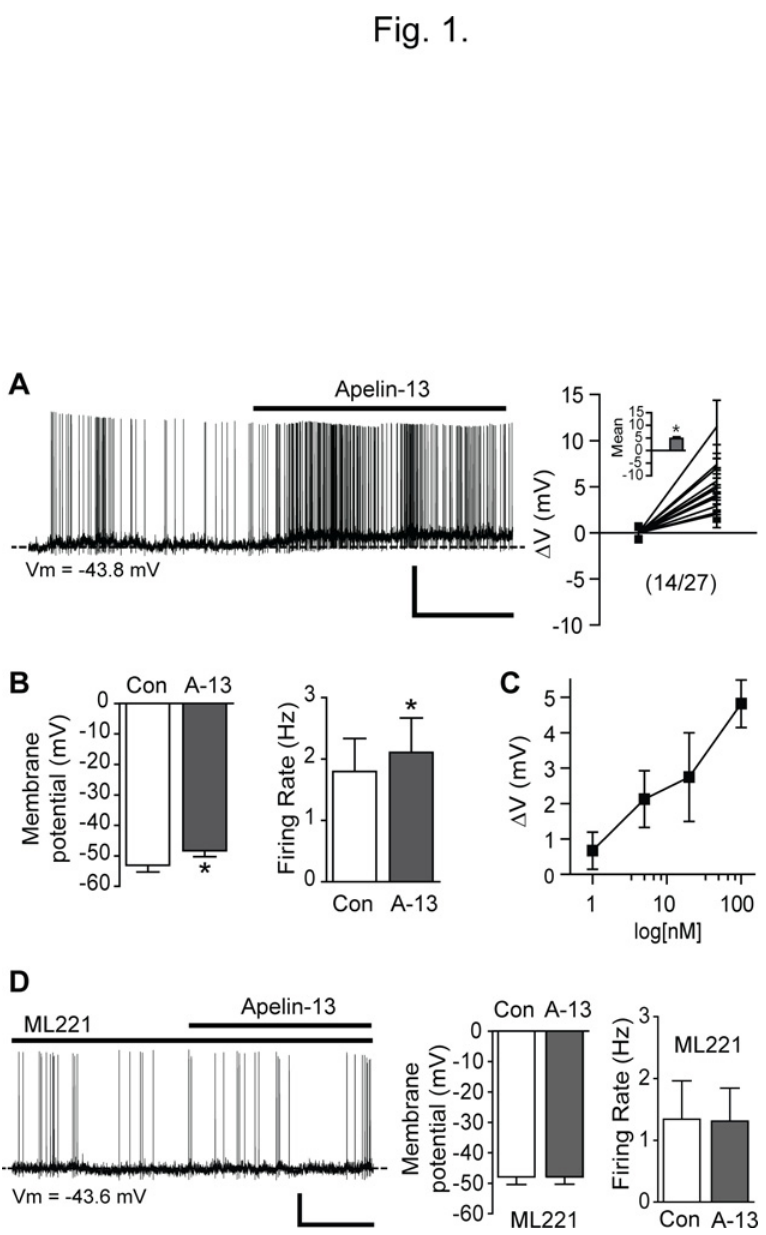
Fig 1. Apelin-13 depolarizes POMC neurons in the ARC. (A) Representative recording sample of the whole-cell membrane potential before, during and after treatment with apelin-13 after having blocked ionotropic glutamate and GABA receptors (left panel). Treatment with apelin-13 (100 nM) induced a depolarization and increased the firing rate of POMC neuron (right panel; mean change in membrane potential: +4.8 ± 0.7 mV, n = 14 neurons, p < 0.05). Scale bar: 20 mV, 2 min. (B) Pooled data of membrane potential and firing rate of POMC neurons with apelin-13 (A-13) (mean membrane potential: before -53.1 ± 2.2 mV vs. after -48.3 ± 1.9 mV, n = 14 neurons, p < 0.05; mean firing rate: before 1.8 ± 0.5 Hz vs. after 2.1 ± 0.6 Hz, n = 9 neurons, p < 0.05). (C) Apelin-13 causes a concentration-dependent depolarization of POMC cells. Depolarization by apelin-13 was determined at 1, 5, 20 and 100 nM in 6, 9, 6 and 14 neurons, respectively. (D). Representative whole-cell recording sample of the electrophysiological effect of apelin-13 in the presence of the APJ receptor antagonist ML221 (20 μ M; left panel). Under these experimental conditions, POMC neurons did not respond to apelin-13 (middle and right panels; n = 11 neurons, p > 0.05). Scale bar: 20 mV, 2 min.